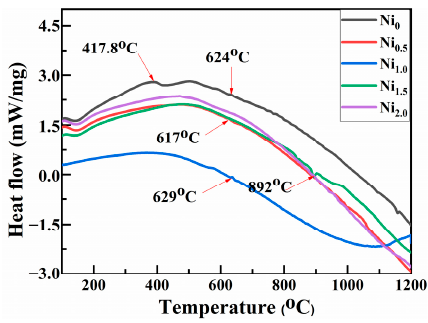
Figure 10. DSC Curves of CoCrCuFeMnNi x HEAPs after 50 h ball milling.